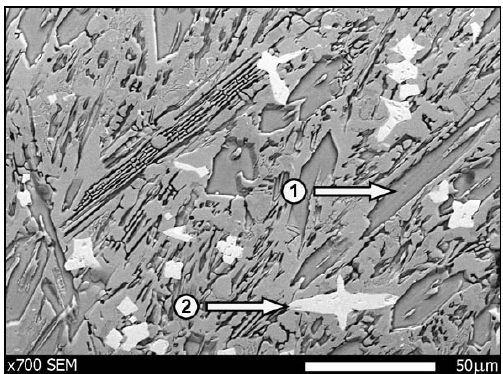
Figure 6. Microscopic image of the padded layer F-61. Microstructure of the padded layer with grains of chromium (1) and niobium (2) carbides. Etched with 3% HNO 3 (Mi1Fe) and electrolytically with chromic acid, scanning microscopy.